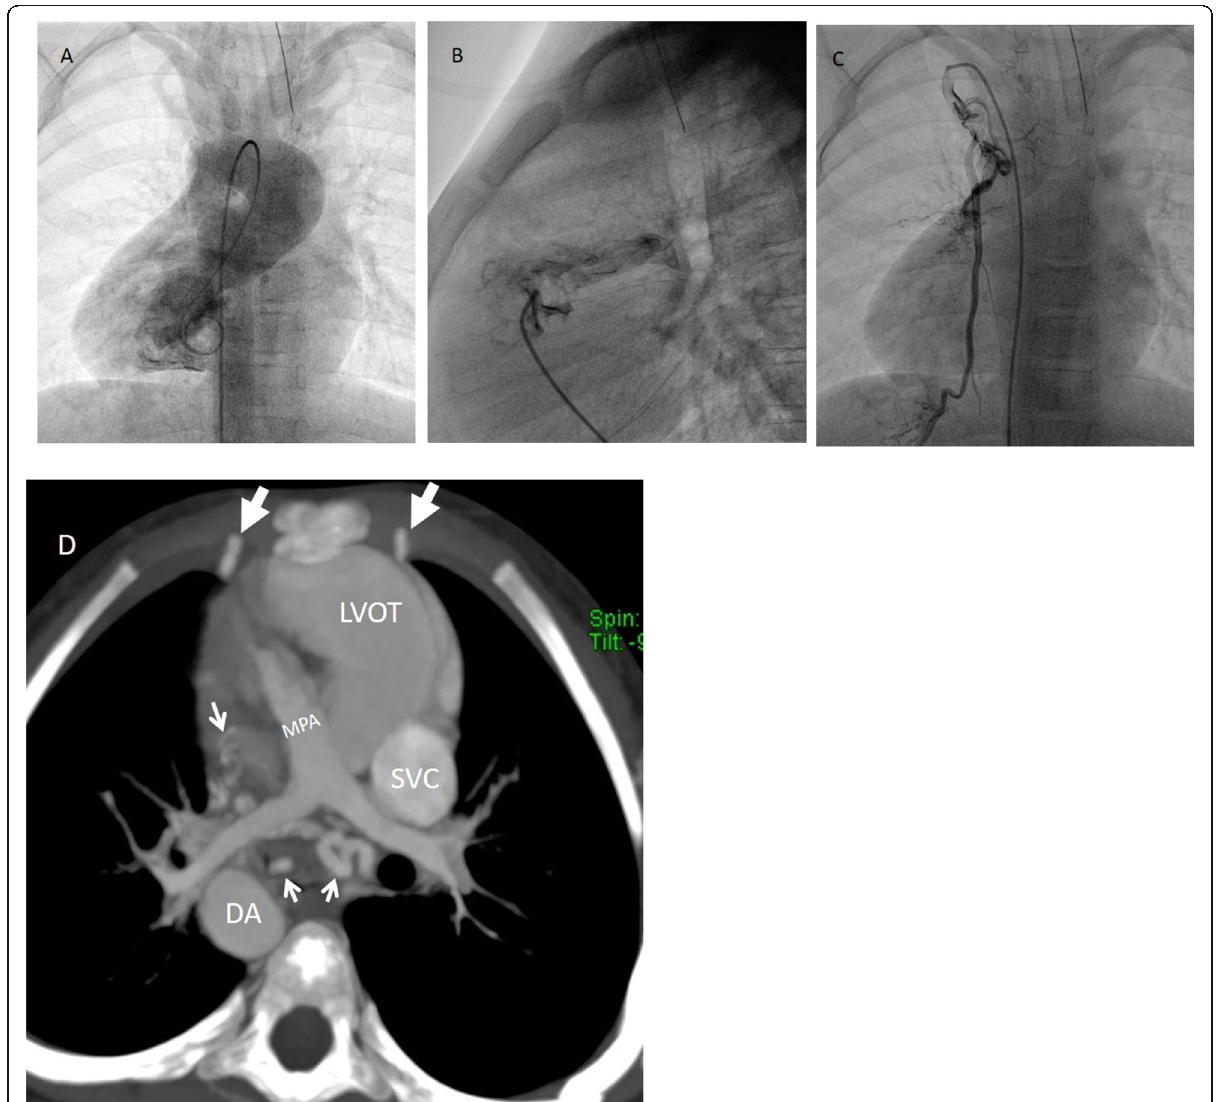
Fig. 3 4-year-old boy with respiratory distress, situs inversus and pulmonary atresia. a Left ventriculography shows the right-sided aortic arch and dilated great arteries. b Right ventriculography shows pulmonary atresia. c Right internal mammary angiography: hypertrophied artery supplying systemic collaterals to the right lung. All angiography series (not shown) failed to delineate the pulmonary arteries. d CTA clearly shows the pulmonary arteries and their diameters in addition to collaterals (arrows) and hypertrophied internal mammary arteries (black arrows). Based